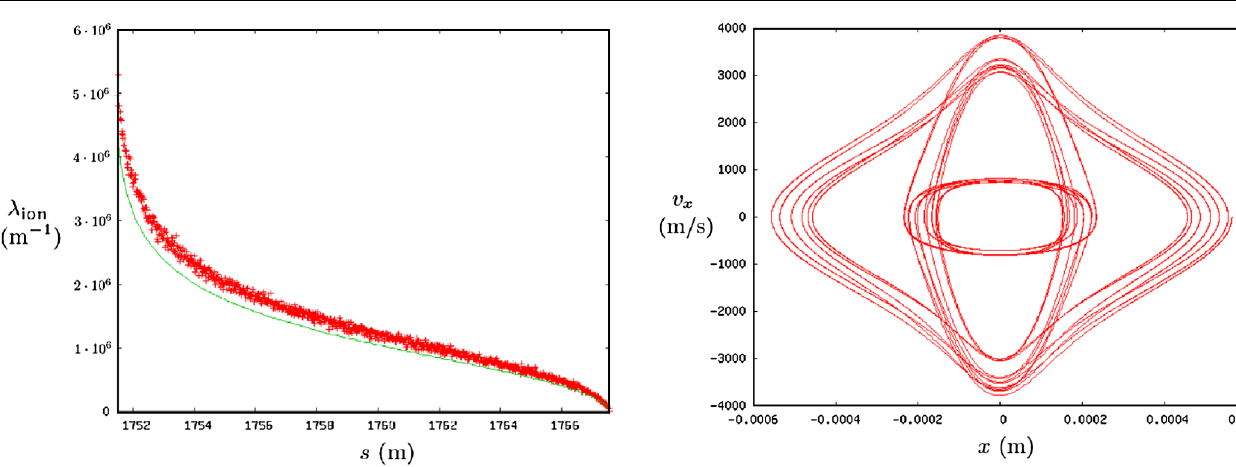
FIG. 13. (Color) Example of nonperiodic transverse ion motion in a nonround beam